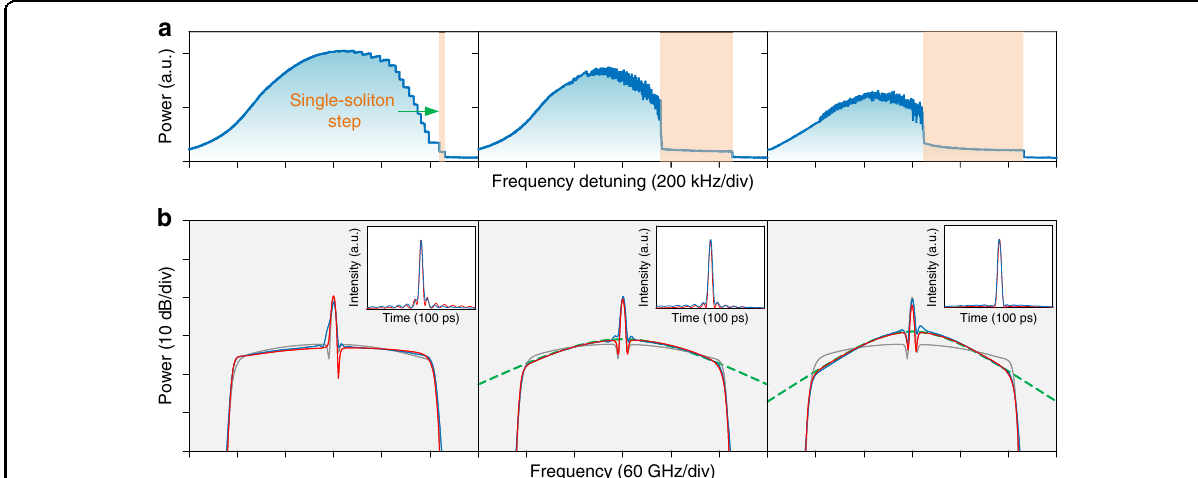
Fig. 5 Relation between fi lter-driven and dispersion-driven solitons. a Intracavity power versus pump frequency detuning. From left to right, the net roundtrip dispersion is 0.63, − 1.06, and − 4.22 ps 2 , respectively. A chaotic region with higher noise can be observed when the dispersion is negative (anomalous). b Soliton spectrum and pulse shape (inset) at the corresponding single-soliton steps (brown regions) indicated in ( a ). Blue, measured; red, simulated. The result with no dispersion is also shown for comparison (gray solid line). With the increase of anomalous dispersion, the pulse transitions from a fi lter-driven Nyquist soliton to a conventional dispersion-driven nonlinear Schrödinger soliton for which the spectral envelope can be well fi tted by a hyperbolic secant function (green dash